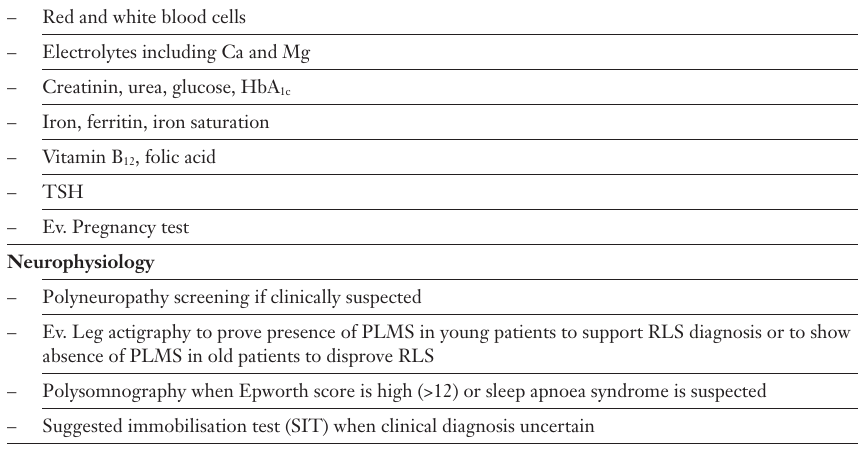
List of diagnostic in- vestigations in